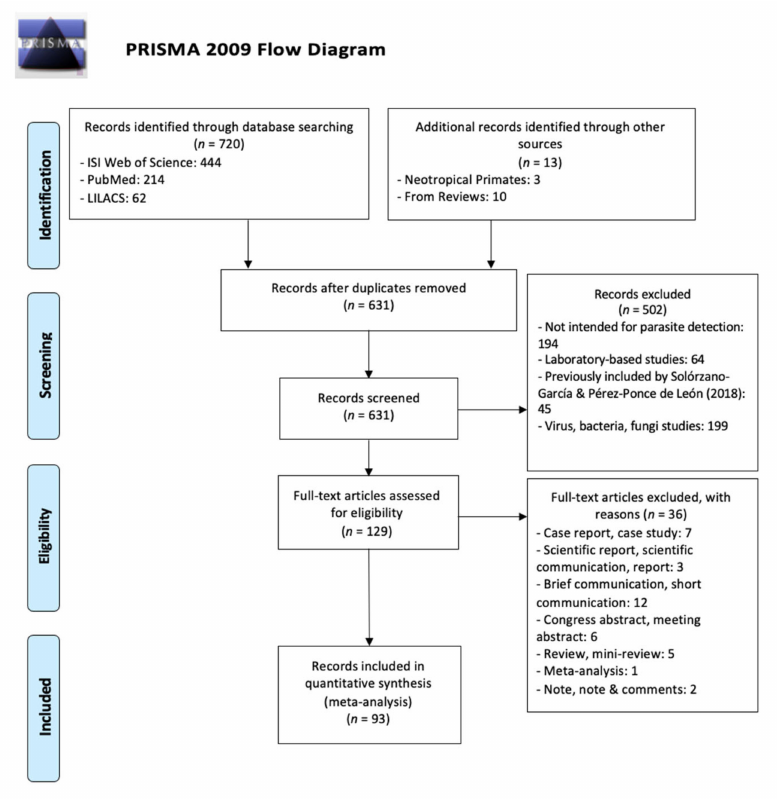
Figure 1. PRISMA Flow